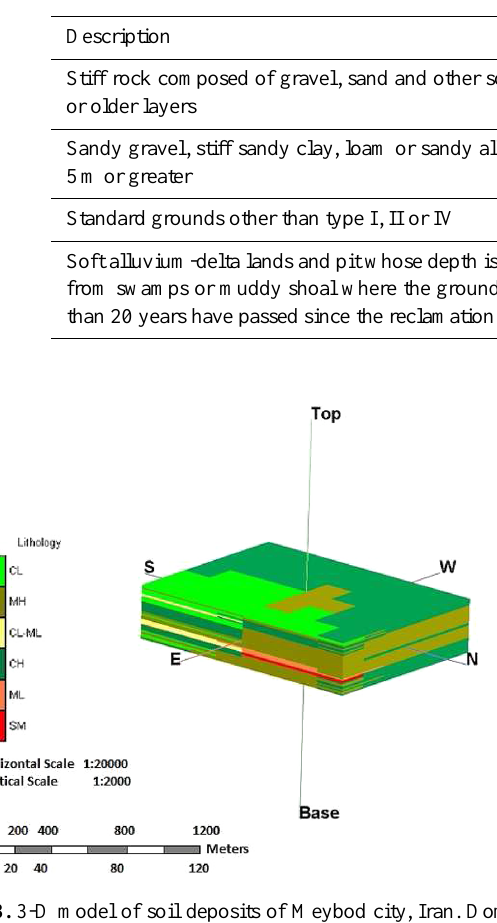
Figure 3. 3-D model of soil deposits of Meybod city, Iran. Domi- nant soil type is composed of clay and silt with high plasticity. The major variation is located in the eastern part of the city (CL: inor- ganic clay of low plasticity or lean clay; MH: inorganic silt of high plasticity; CL-ML: inorganic clay and inorganic silt of low plastic- ity; CH: inorganic clay of high plasticity; ML: inorganic silt of low plasticity; SM: silty